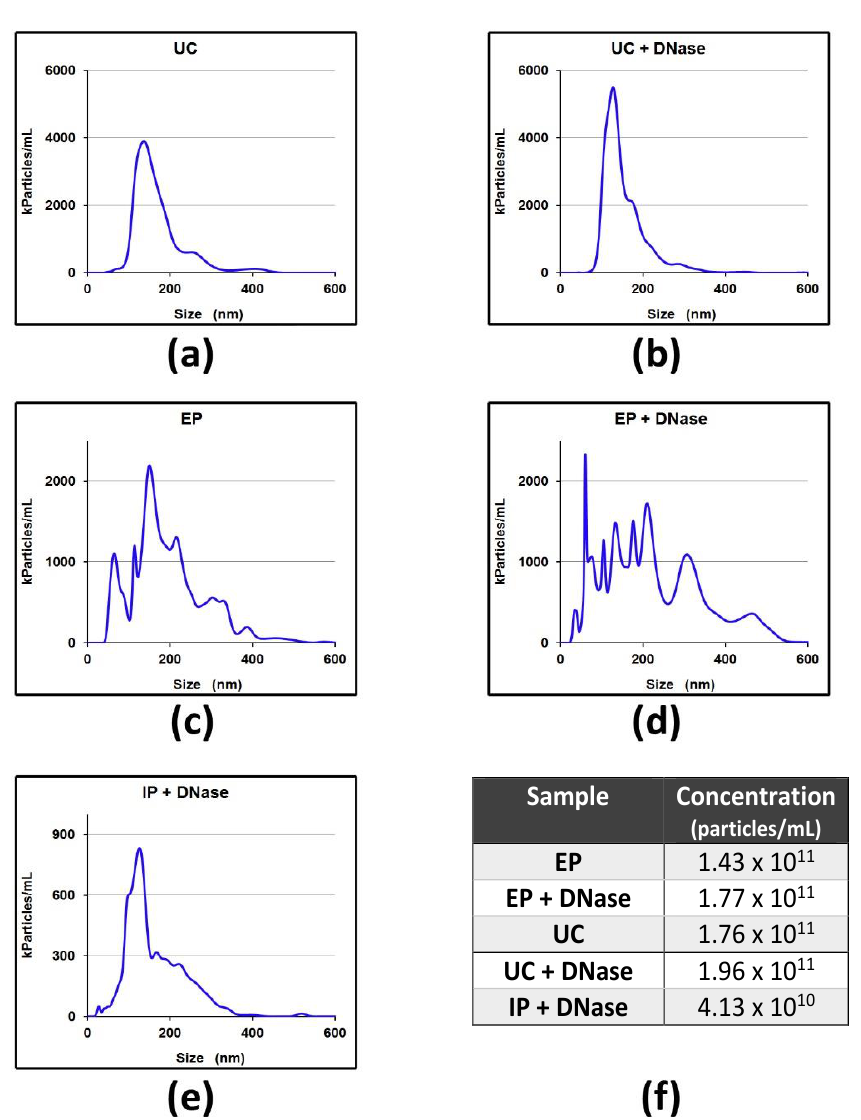
Figure 3. Nanoparticle tracking analysis of sEVs separated from plasma using ultracentrifugation (UC) ( a ), the Exosome Precipitation kit (EP) ( c ) or DNA-directed immunoprecipitation (IP) ( e ). Samples deriving from EP and UC were further treated with DNase I and particle size after enzymatic treatment are show in ( b , d ), respectively. sEV concentration, reported as particles/mL, is also shown ( f